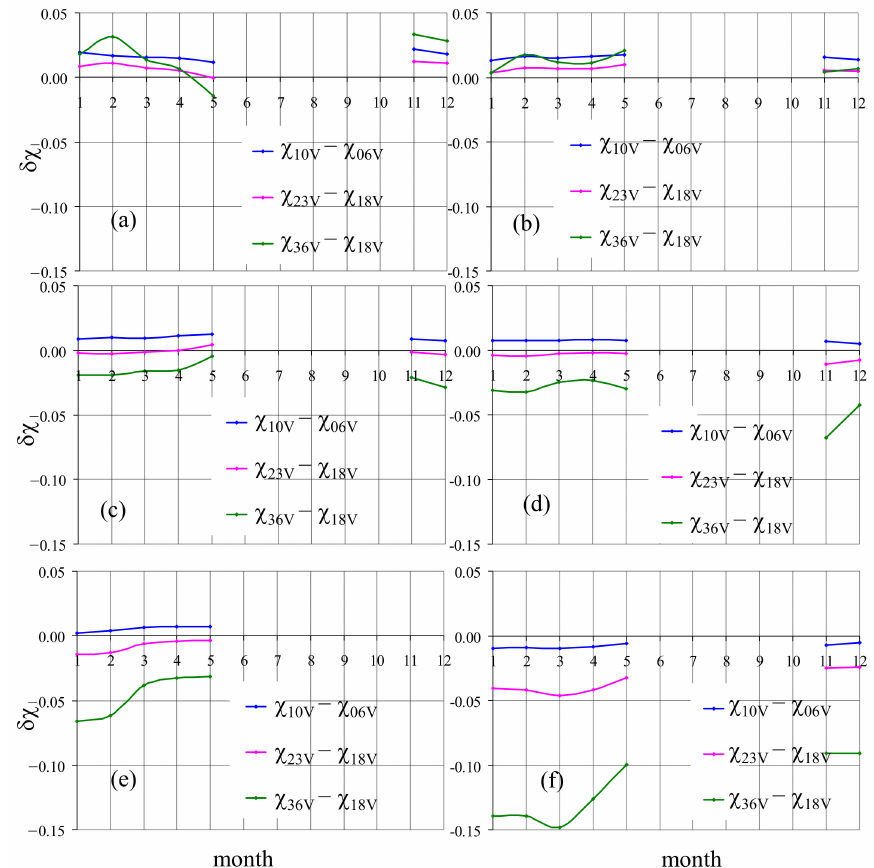
Figure 8. Monthly averaged values of δχ 1, δχ 2 and δχ 3 ( δχ 1 = χ 10V − χ 06V , δχ 2 = χ 23V − χ 18V , δχ 3 = χ 36V − χ 18V ). ( a )—nilas, ( b )—young ice, ( c )—thin FY ice, ( d )—medium FY ice, ( e )—thick FY ice, ( f )—MY